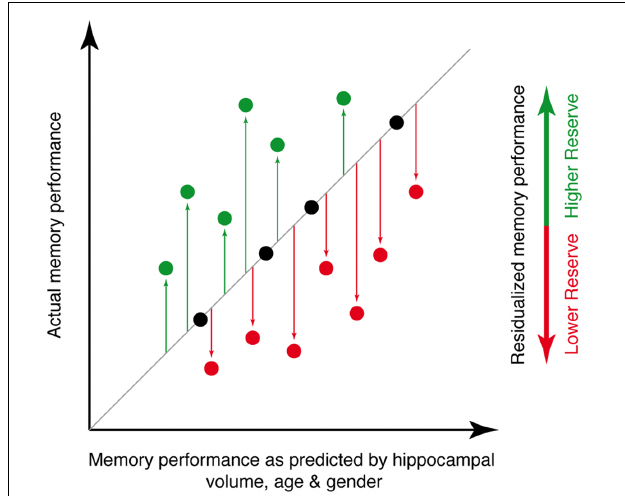
FIGURE 2 | Illustration of the principle underlying the memory reserve measure used for the current study. The actual level of memory performance is plotted against the memory performance as predicted by age, gender and hippocampal volume. Individuals whose actual memory performance level is higher than predicted (green circles) have high memory reserve, whereas individuals whose actual memory performance is lower than predicted (red circles) have low memory reserve.